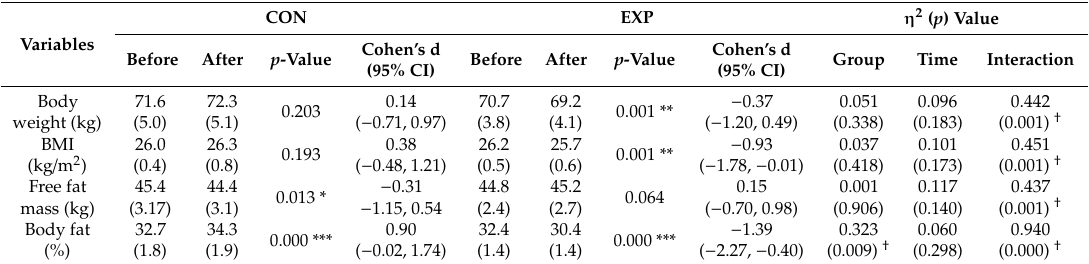
Table 2. Changes in body composition before and after 12-week